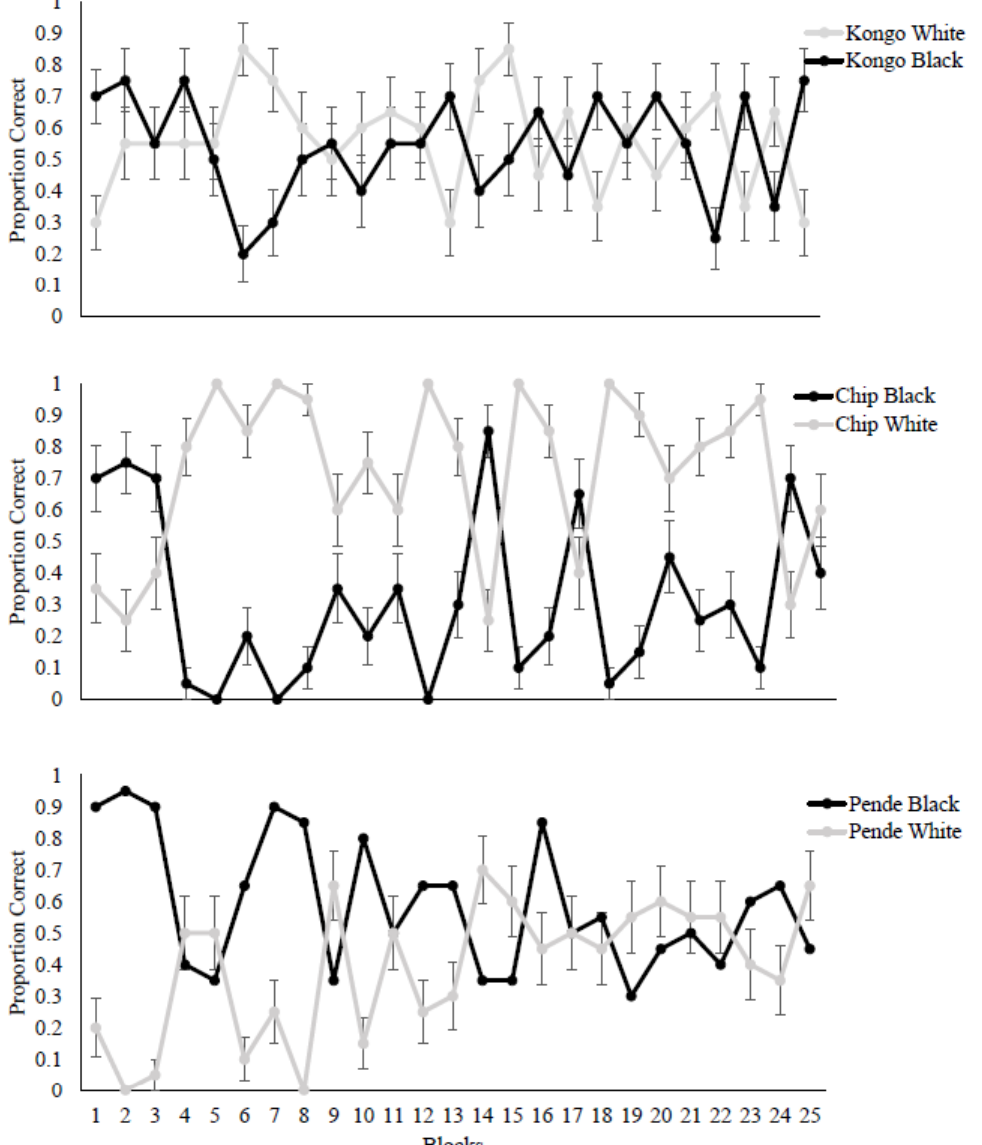
Figure 4 . Proportion of correct selections (with SEM) for both black and white background trials during the training phase in blocks of four sessions for each